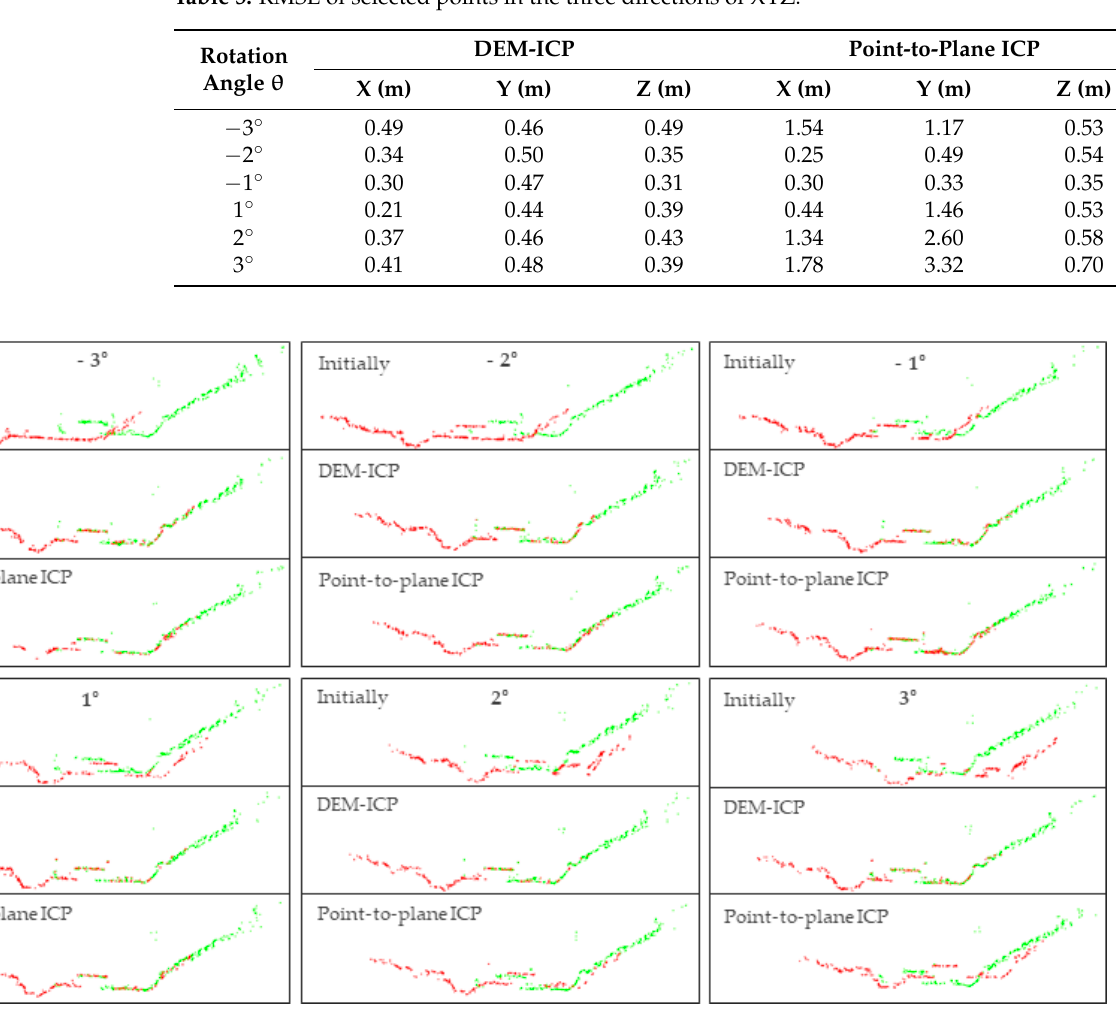
Figure 11. Slices of registration results in the performance comparison experiment. The green point cloud is Strip 3 and the red one is Strip 6. The slice position is the same as the lateral slice in Figure 6c.